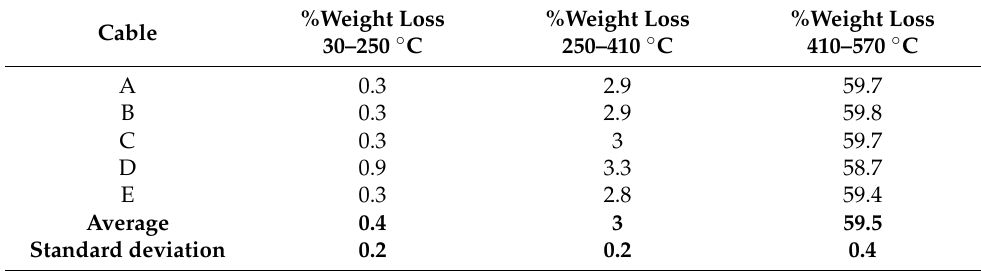
Figure 3. TGA curves of the insulation layer for virgin and naturally aged cables, under condition I (heating rate of 10 ◦ C min − 1 ). A–E stand for different ESP cables as denoted in the Section 2. Table 2. Weight losses of the insulation layer for the cables A–E evaluated under condition